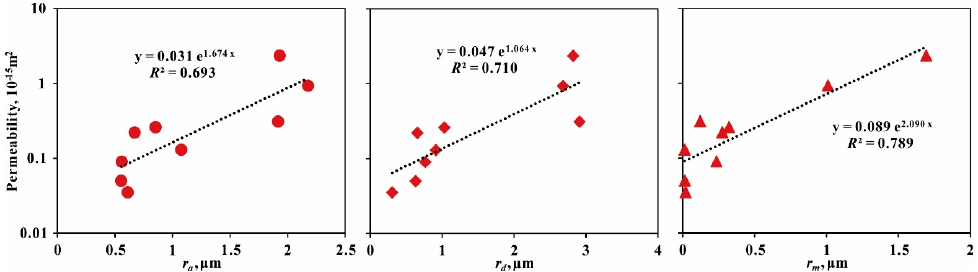
Figure 9. Correlations between permeability and r a (average throat radius), r d (maximum connected throat radius corresponding to displacement pressure), r m (mainstream throat radius) obtained from the RMIP method.